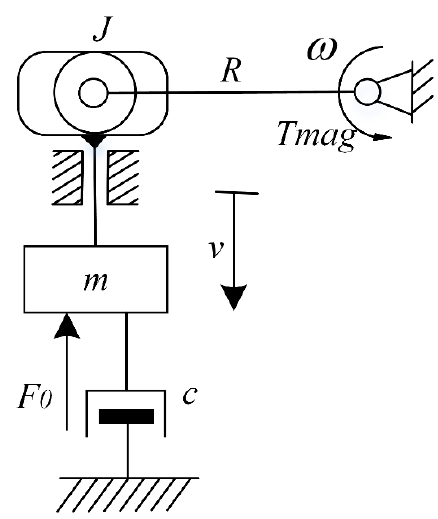
Figure 6. Diagram of the dynamical model.